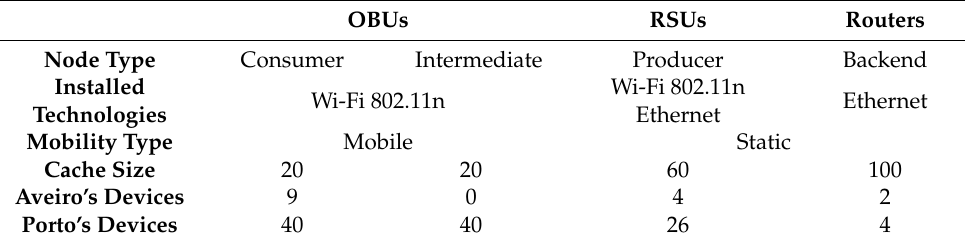
Table 2. Network element’s